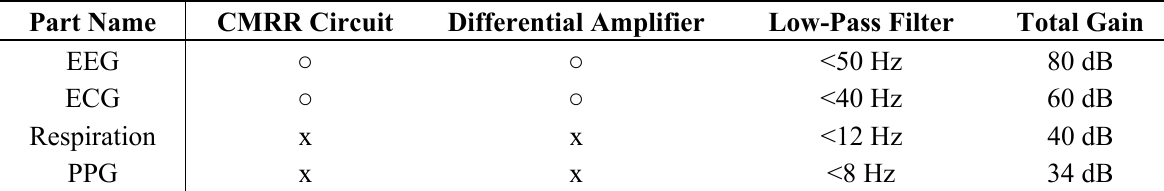
Table 1. Body-signal specifications.